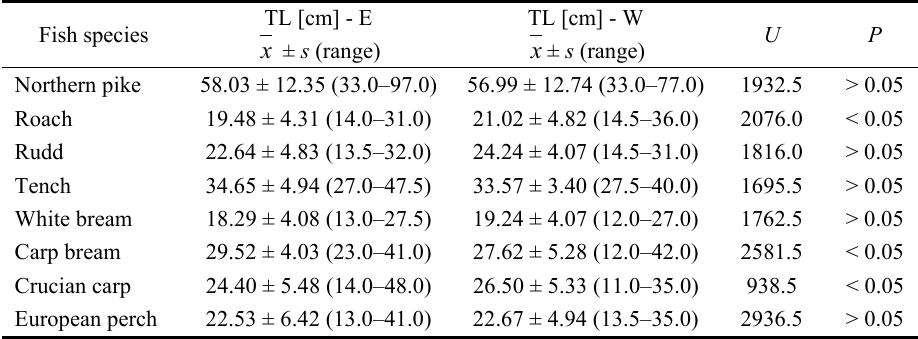
Comparison of the total body length (TL) of fish sampled in the eastern (E) and western (W) part of OÊwin Lake. U , Mann–Whitney